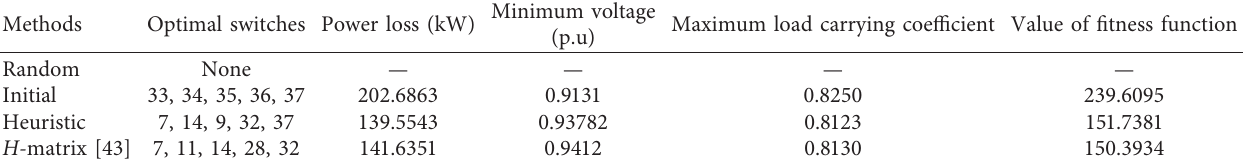
Table 1: The initial solution attached to the initial population for the 33-node system.